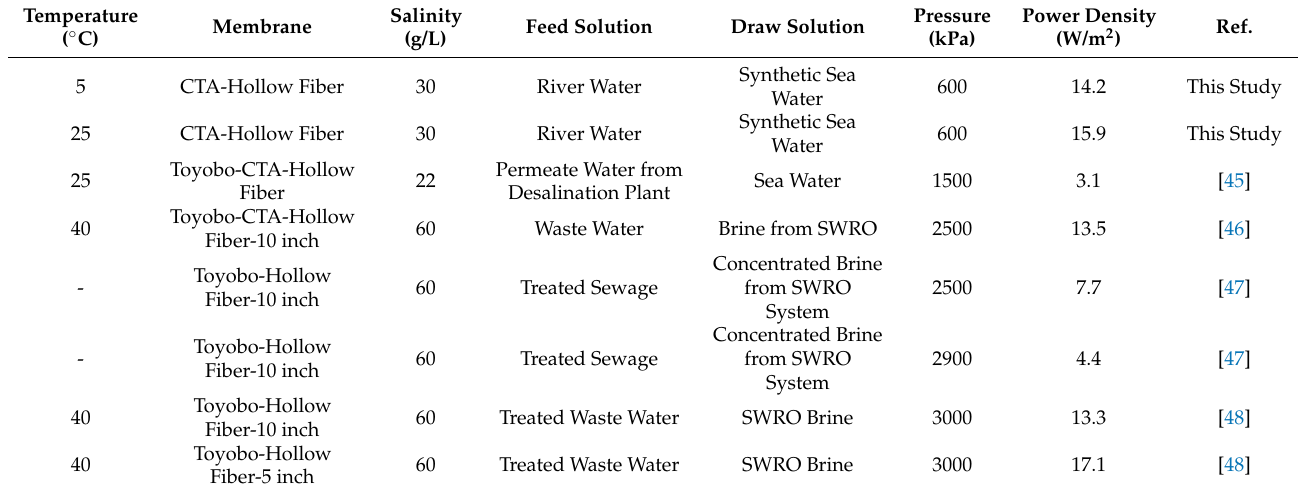
Table 3. Comparison between PRO performance in this study and other reported studies in the literature using commercial hollow fiber